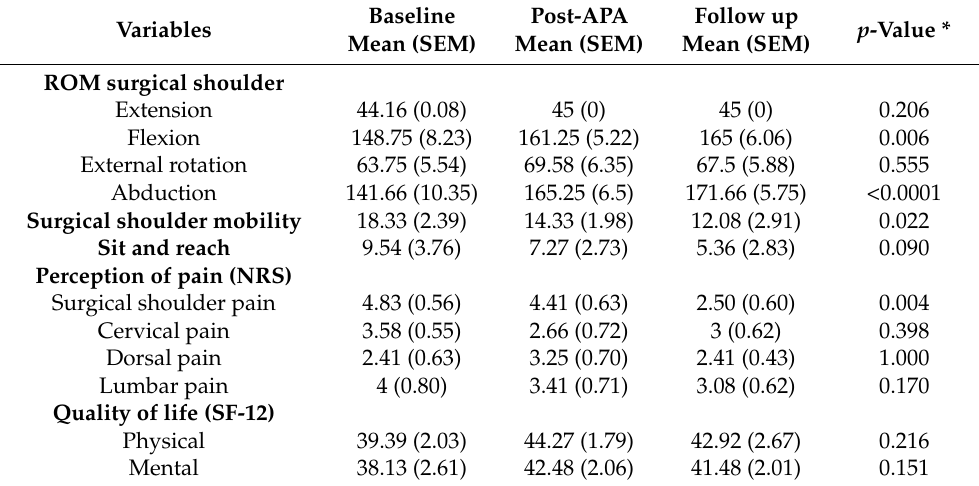
Table 2. Mean scores of fitness tests, pain intensity, and quality of life questionnaires at the baseline, after the APA intervention and at follow up (two years after the APA intervention) in all study participants ( n =